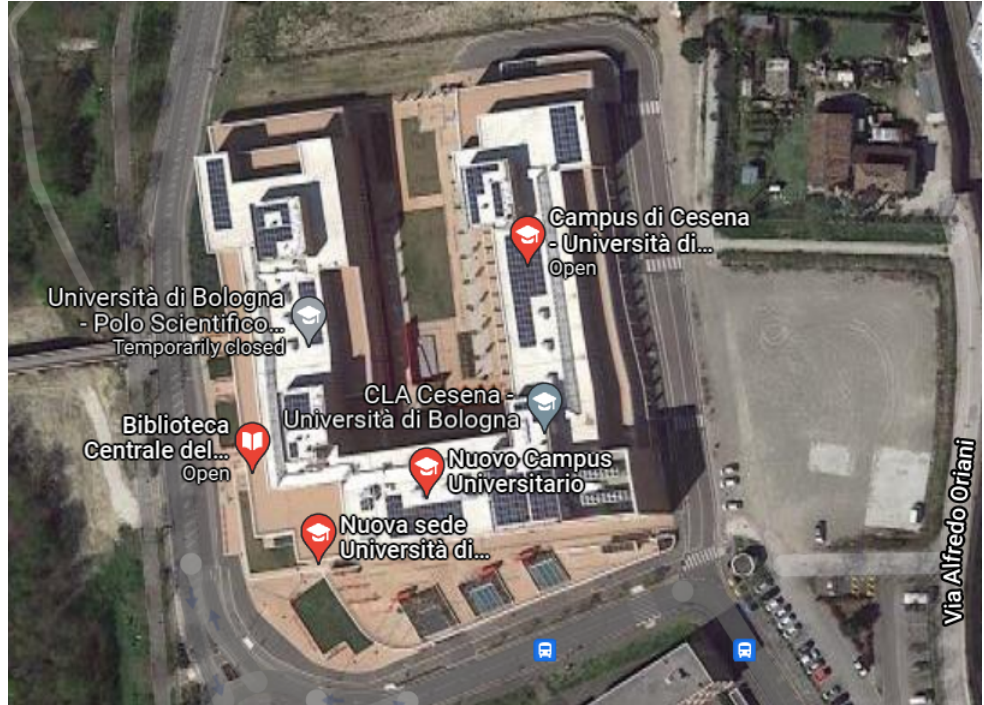
Figure 1. A satellite view of the new Cesena Campus